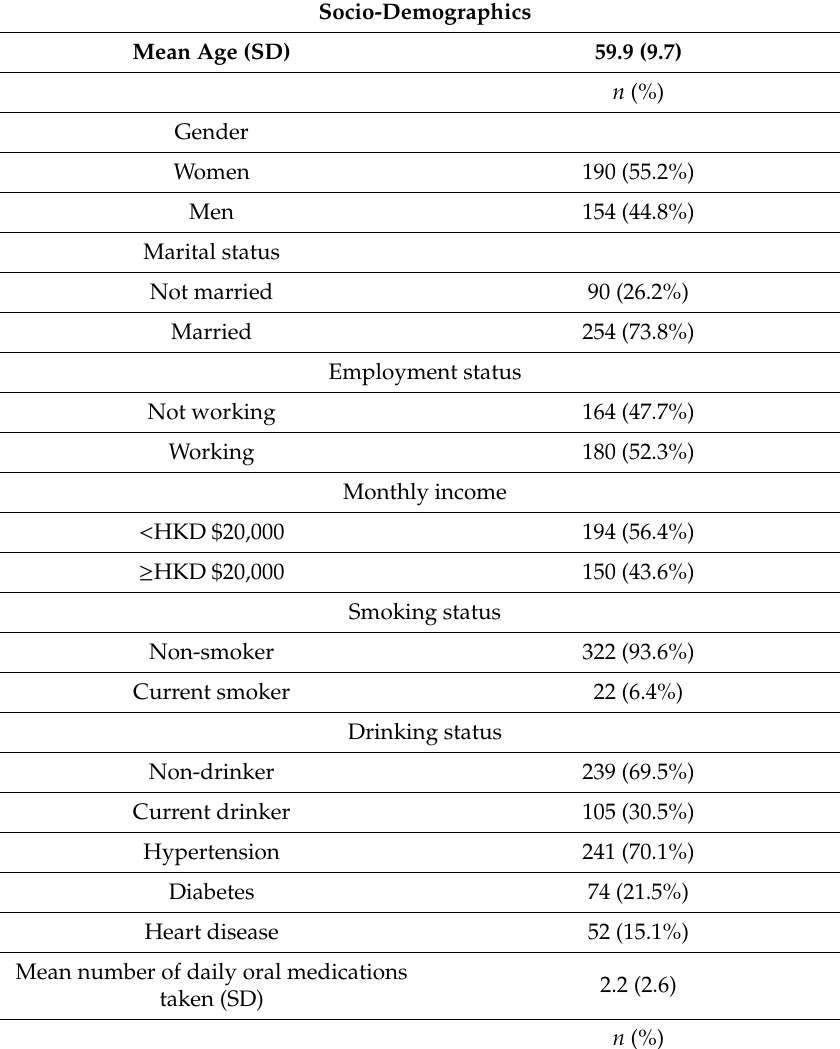
Table 1. Characteristics of participants and study outcomes ( n =